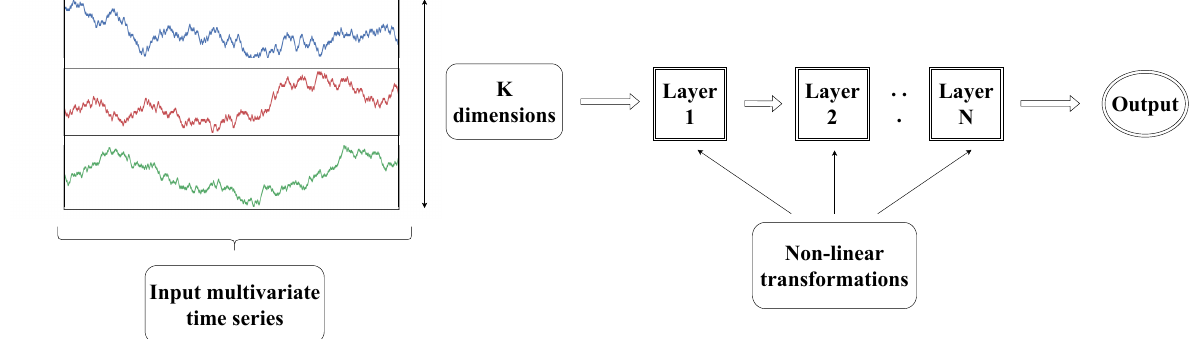
Figure 3. Deep learning framework for time series